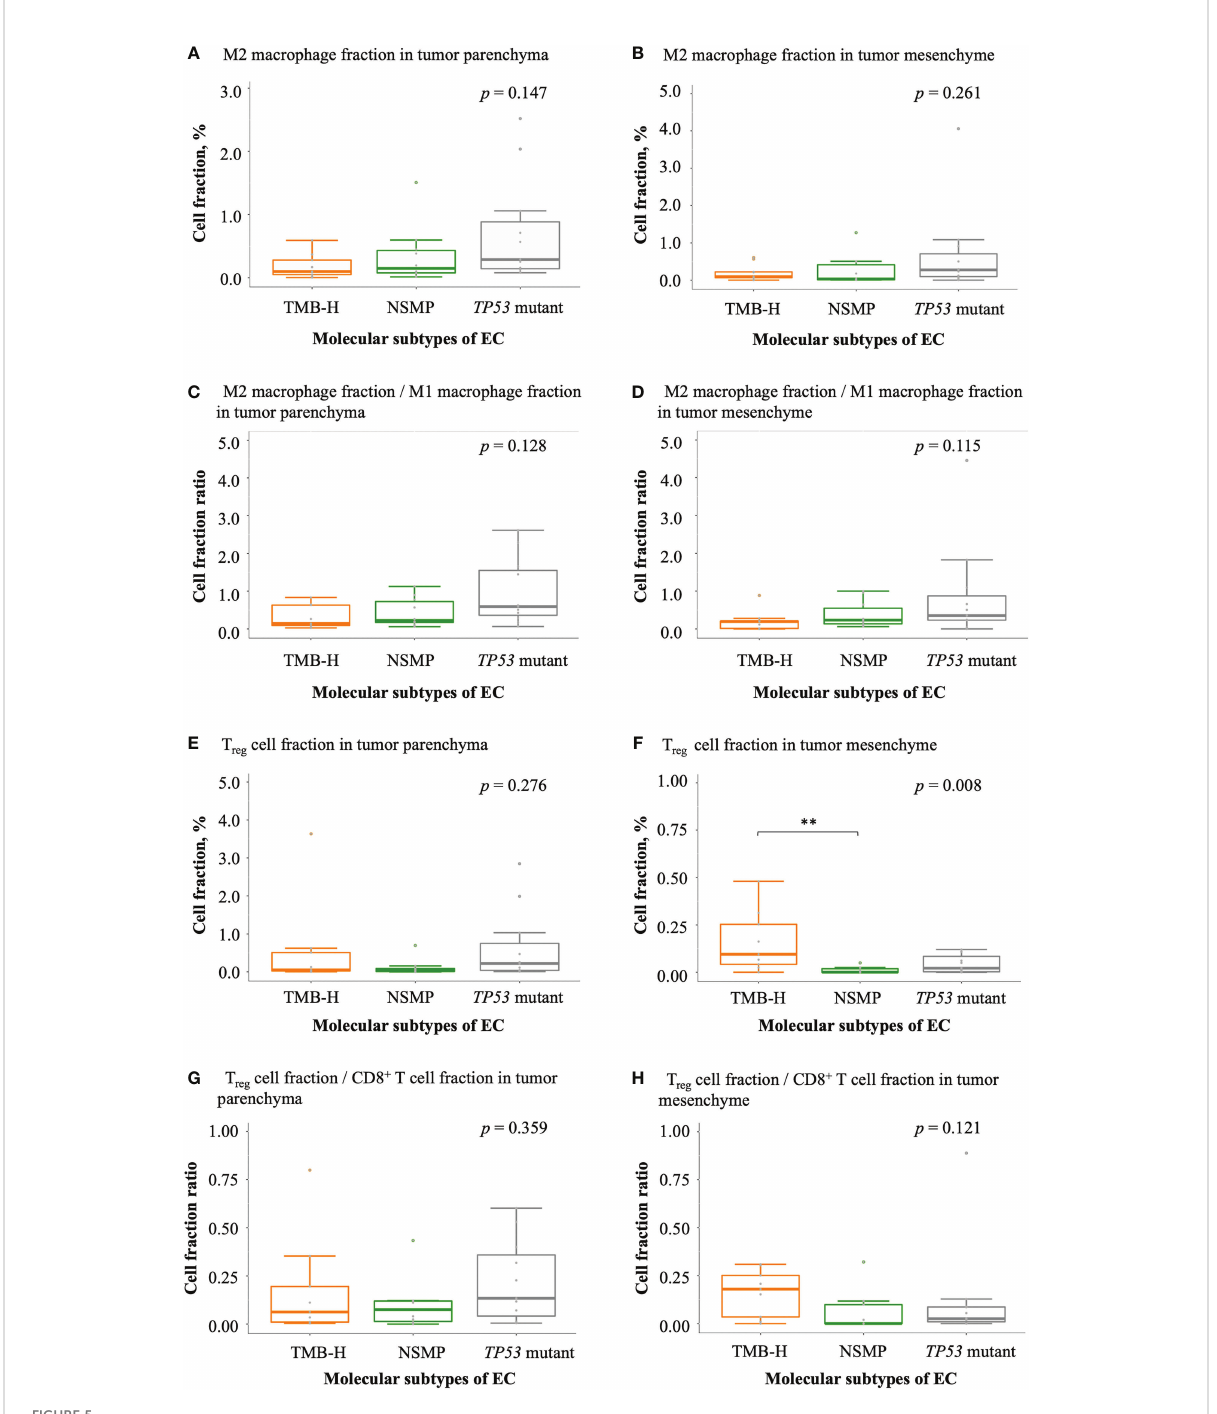
FIGURE 5 In fi ltration of negatively regulatory immune cells in EC. (A, B) M2 macrophage fractions in tumor parenchyma and mesenchyme. (C, D) The ratio of M2 macrophage fractions to M1 macrophage fractions in tumor parenchyma and mesenchyme. (E, F) T reg cell fractions in tumor parenchyma and mesenchyme. (G, H) The ratio of T reg cell fractions to CD8 + T cell fractions in tumor parenchyma and mesenchyme. The p values of Kruskal-Wallis test for overall comparisons are given, and signi fi cant levels in pairwise comparisons are shown in the fi gure. In all panels, n = 9 for TMB-H, 10 for NSMP, 11 for TP53 mutant. The dots above the boxplots indicate outliers. TMB-H, high tumor mutation burden; NSMP, no speci fi c molecular pro fi le; EC, endometrial cancer; T reg cell, regulatory T cell. ** p <